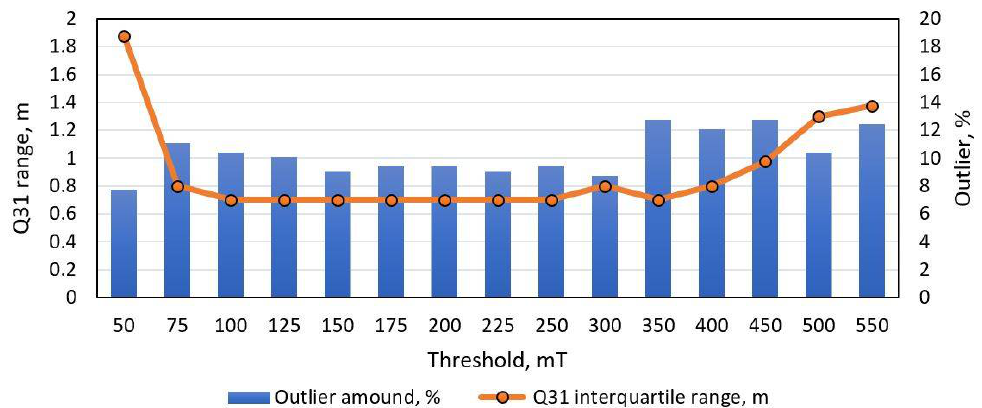
Figure 12. Peak-detection length estimation method performance with dataset of 300 unique vehicle. The orange line depicts error interquartile range, while blue columns indicate the number of outliers.